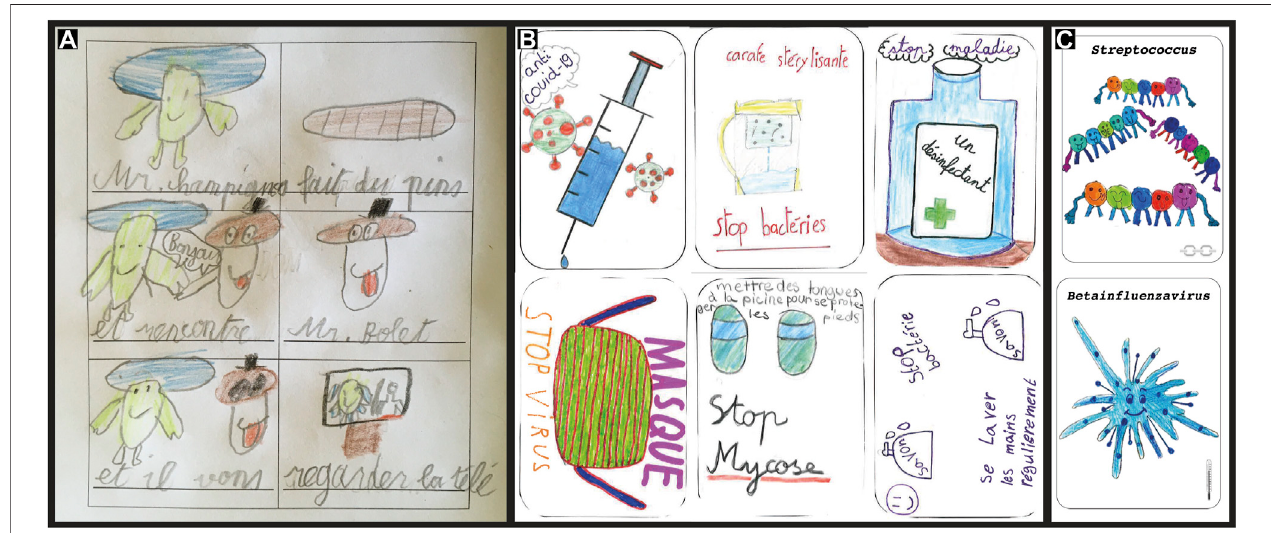
FIGURE3| Evaluationmethods. Forthe6to8yearsoldpupils,thechildrencompletedasmallstorylinewithdrawingsandkeywordstoillustratethatweuseyeast to make bread (A) . In the evaluation method used for 9 to 11 years old pupils, the children could create their own bonus game card. Depending on the game, the pupils drew cards representing ways to be protected against microorganisms (B) or designed their own microorganisms (C) .